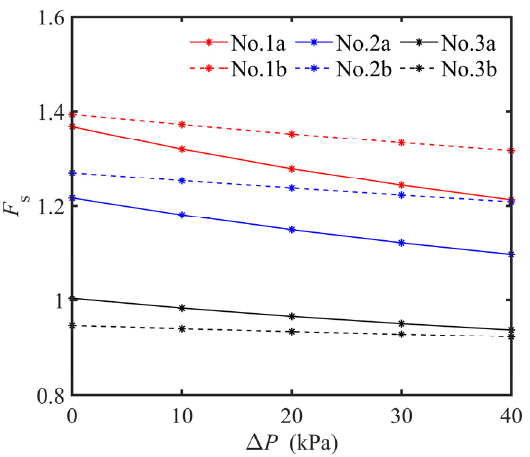
Figure 9. Relationship between the safe factor of local stability and ground overload.